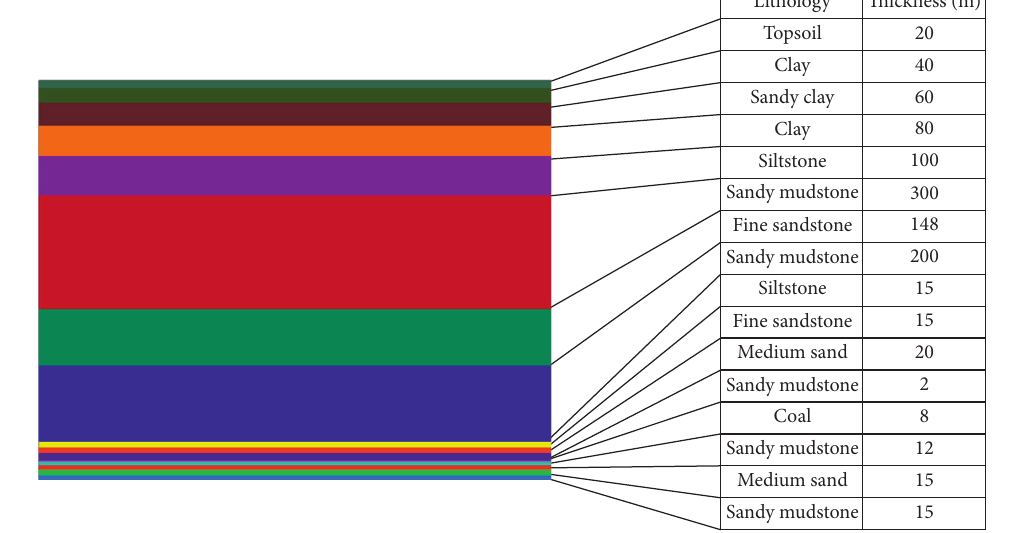
Figure 3: 16 strata of the numerical